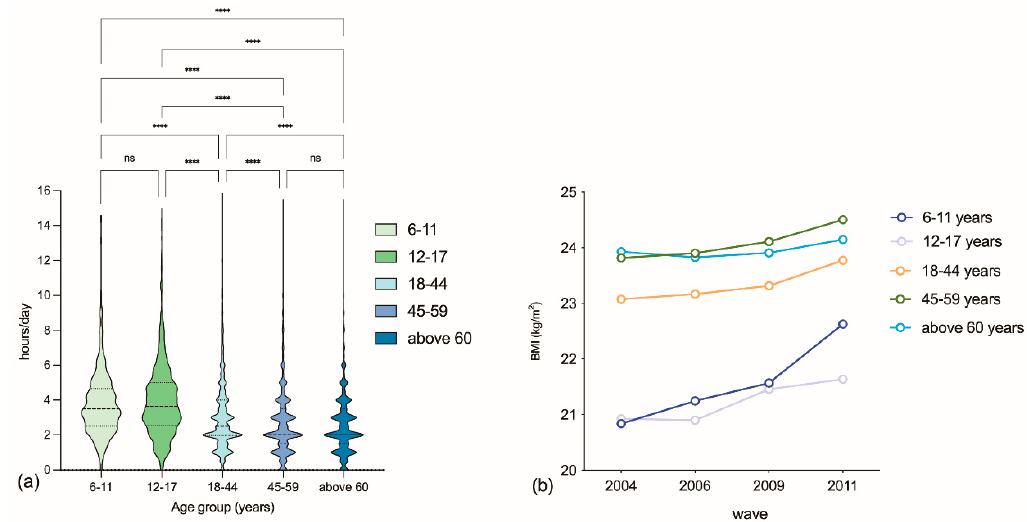
Figure 1. ( a ) Total daily leisure-time sedentary behaviors by age group among the Chinese popula- tion, CHNS 2004-2011; ( b ) BMI by age groups and survey years among the Chinese population; **** : p < 0.0001; ns: not significant.